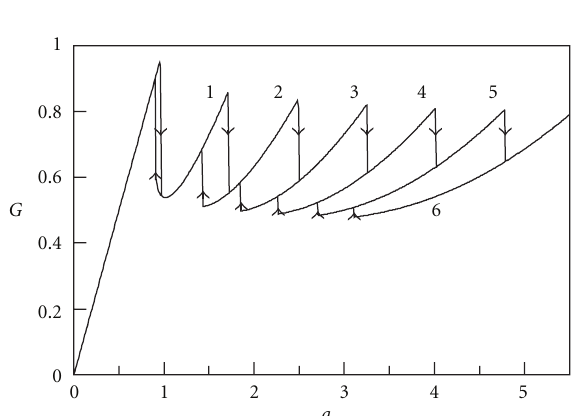
Figure 6: Dependence of the gain G on pumping a .